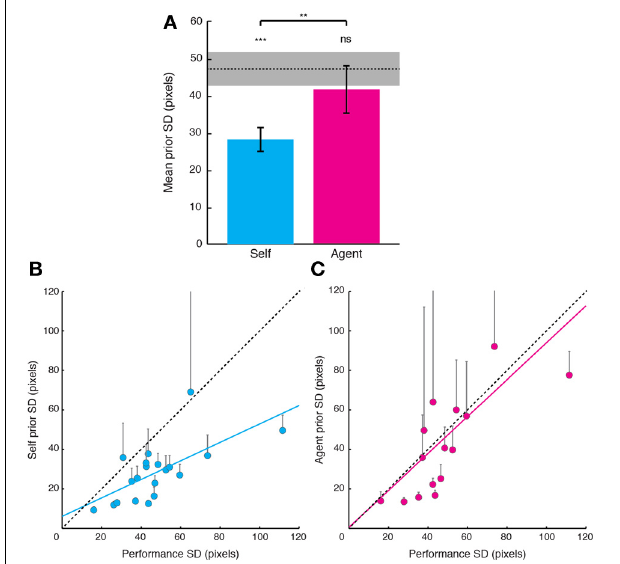
FIGURE 2 | Relations between priors for one’s own actions, priors for observed actions and distributions of performance errors. (A) Comparison of priors with performance SDs. Priors were narrower than performance distribution in the Self condition. By contrast, in the Agent condition, the SDs of priors were not different from performance in the 15 of 20 participants who showed Agent priors. Error bars indicate standard error of the mean. Shaded gray bar indicates the group standard error of the mean for performance errors. Significance levels indicated by ∗∗∗ p < 0 . 001, ∗∗ p < 0 . 01. (B) Self prior SDs plotted against performance error SDs. A significant correlation emerged across subjects (cyan regression line). Data of 18 of the 20 participants lie below the line of equality (black dashed line). Error bars indicate 95% confidence bounds. (C) Same as (B) , but for Agent priors against performance error